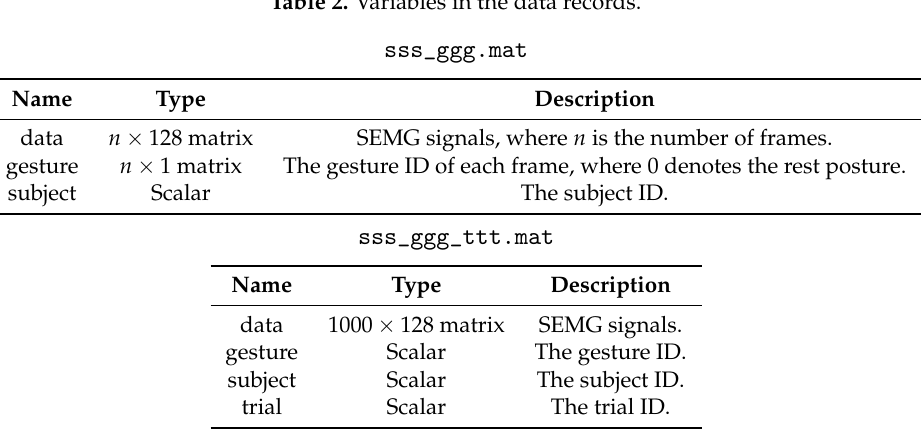
Table 2. Variables in the data records.